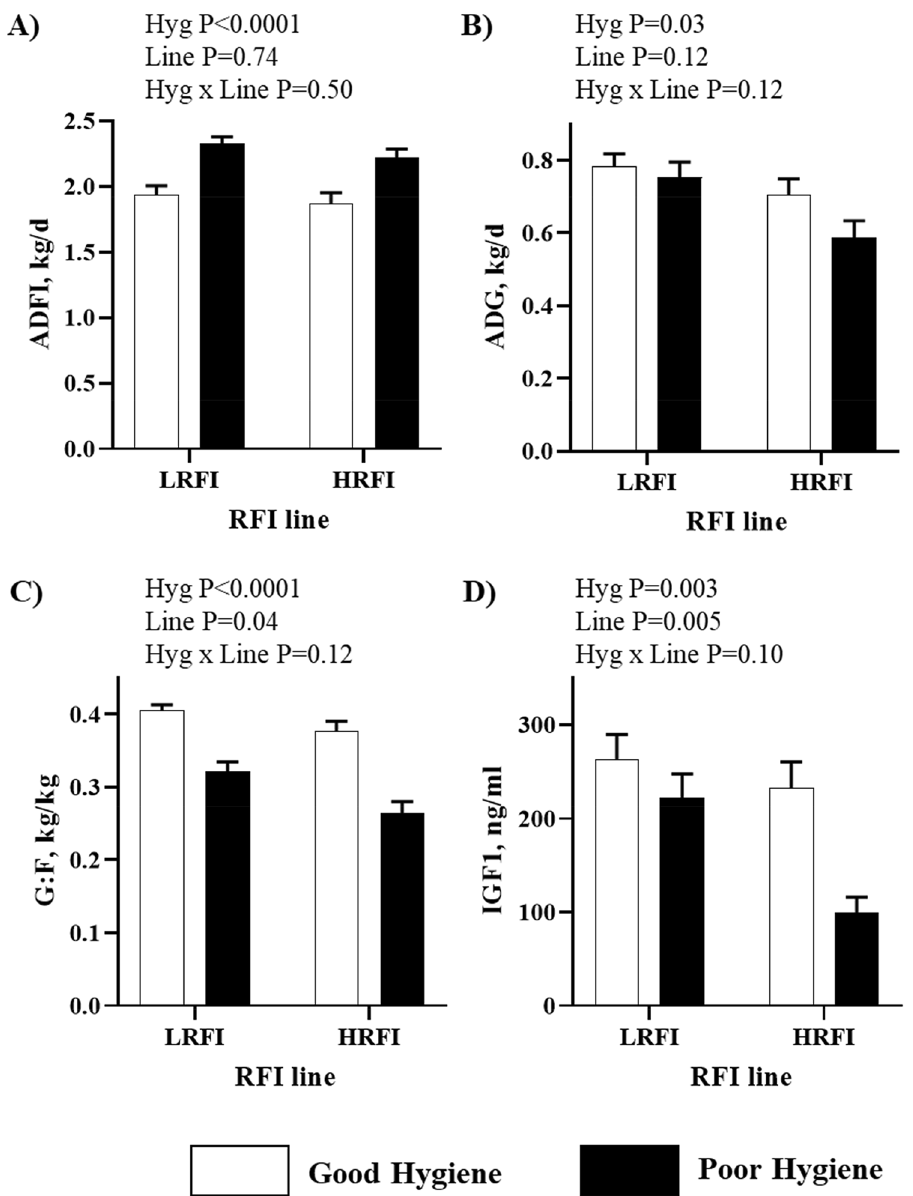
Figure 1. Effect of poor versus good hygiene condition (Hyg) on growth performance and plasma IGF-I concentration of pigs divergently selected for low or high residual feed intake (LRFI and HRFI lines). ( A ) Average daily feed intake (ADFI), ( B ) Average daily gain (ADG), ( C ) Gain to feed ratio (G:F), and ( D ) Insulin-like growth factor-I (IGF1). Means ± standard error of the mean are reported on figures (n = 6 to 10/ experimental